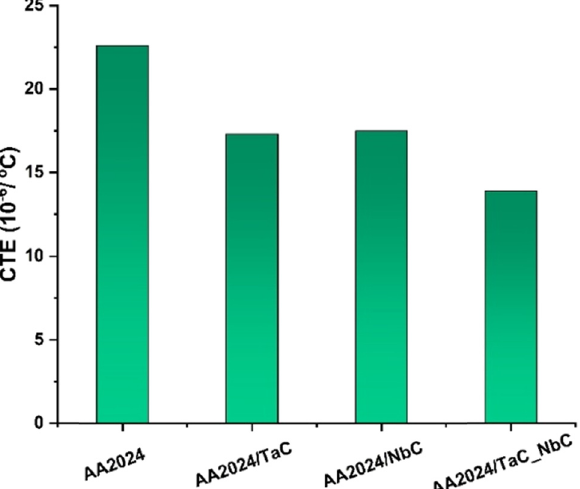
Figure 11: CTE values of AA2024 and its composites.